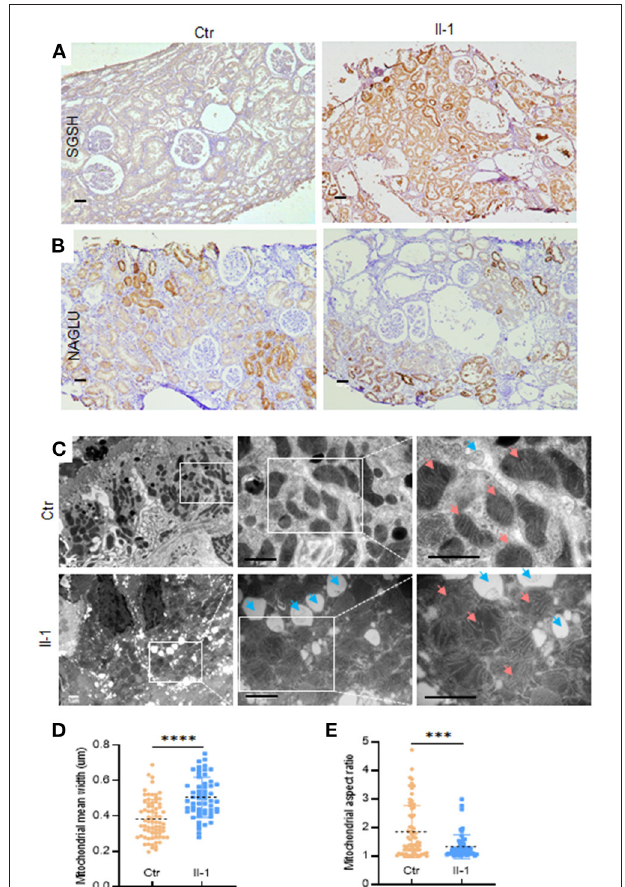
FIGURE 4 | The expression of SGSH in biopsies and TEM of mitochondria and lysosomes in tubular epithelial cells. (A) Immunohistochemical staining of SGSH in control (Ctr) and proband (II-1), scale bar = 100 µ m. (B) Immunohistochemical staining of NAGLU in control (Ctr) and proband (II-1), scale bar = 100 µ m. (C) TEM images of proximal tubular epithelial cells from the kidney biopsies of controls and patients with ARPKD. Blue arrows = lysosomes; pink arrows = mitochondria. Scale bar = 1 µ m. (D) Quantification of mitochondrial width at × 30,000 magnification. (E) Quantification of mitochondrial aspect ratio. Calculations were based on three random high-power fields ( × 30,000). Each dot denotes the value of a single mitochondrion. Data are the mean ± SD. *** P < 0.001 and **** P <